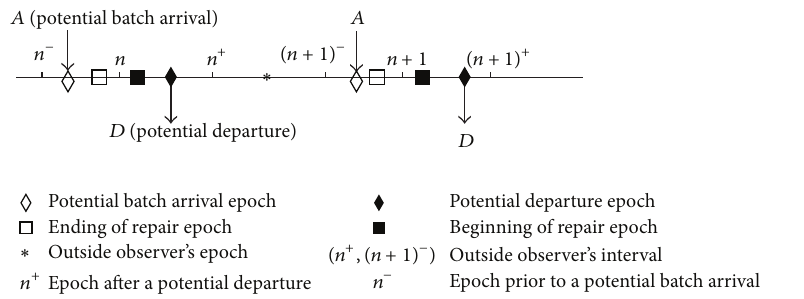
Figure 1: Various time epochs in a late arrival system with delayed